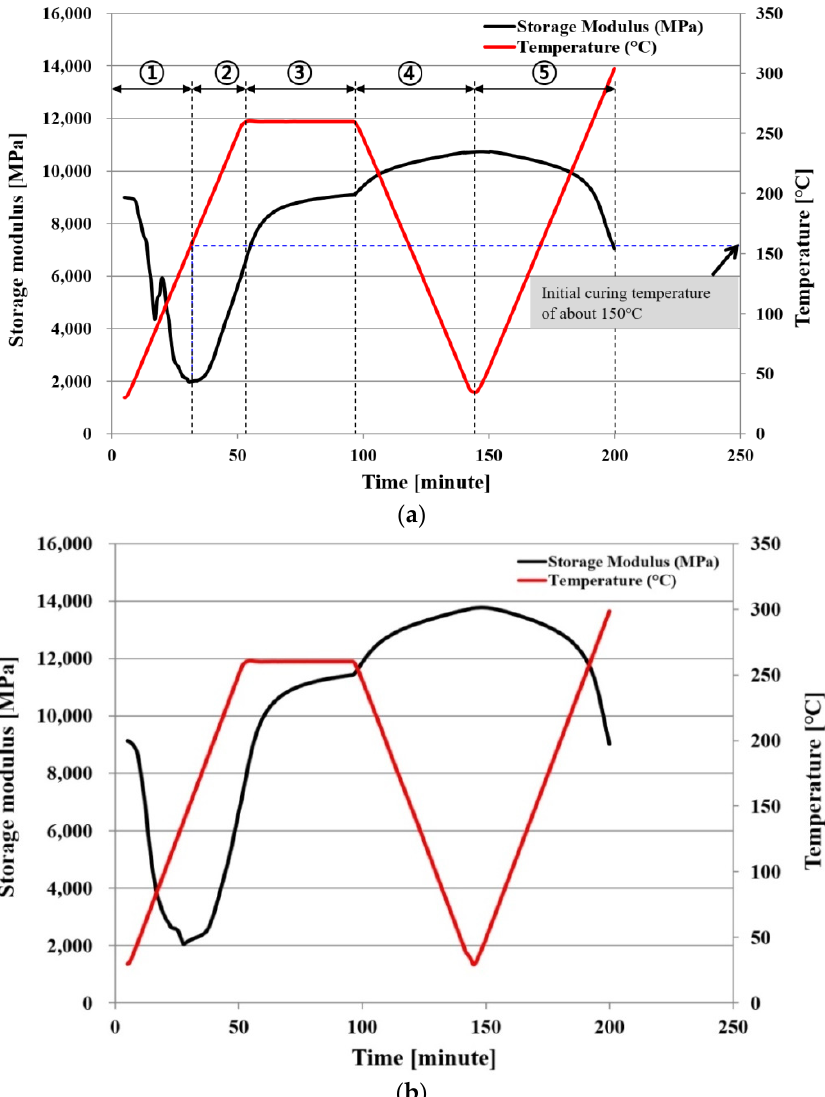
Figure 2. Storage modulus of PPG as a function of temperature and time: ( a ) x direction; ( b ) y direction.